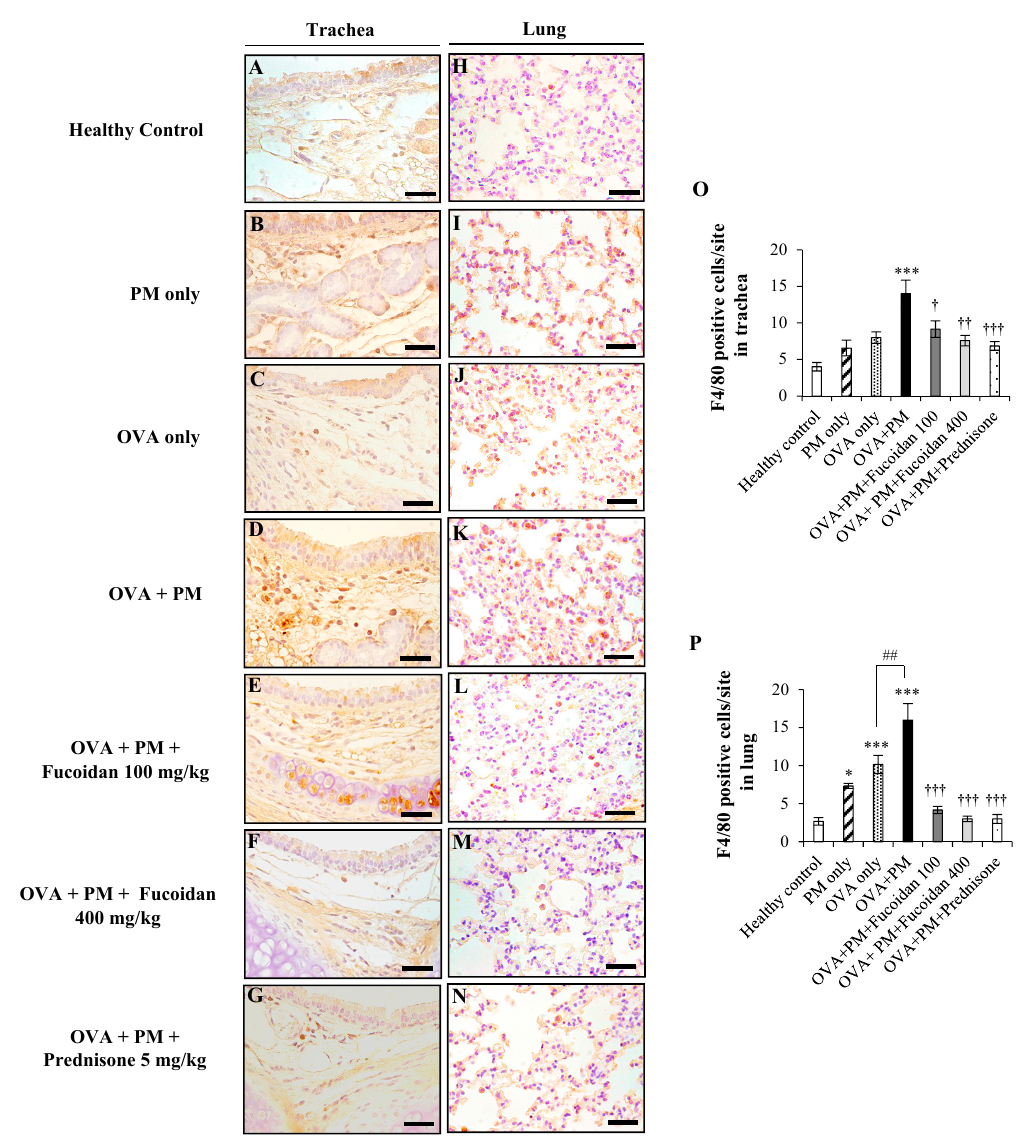
Figure 6. Immunohistochemical analysis of F4 / 80 + macrophage cells in the trachea ( A – G ) and lungs ( H – N ). ( A , H ) Healthy control, ( B , I ) PM only, ( C , J ) OVA only, ( D , K ) OVA + PM, ( E , L ) OVA + PM + Fucoidan (100 mg / Kg), ( F , M ) OVA + PM + Fucoidan (400 mg / Kg), ( G , N ) OVA + PM + Prednisone (5 mg / Kg). ( O ) Number of F4 / 80 + cells per site in the trachea, ( P ) Number of F4 / 80 + cells per site in the lungs. Values are expressed as means ± SEM ( n = 3). * ( p < 0.05), *** ( p < 0.0005) represent significant increases compared with the healthy control, and † ( p < 0.05), †† ( p < 0.005), ††† ( p < 0.0005) denote significant decreases compared with the OVA + PM group. ## denotes a significant increase ( p <